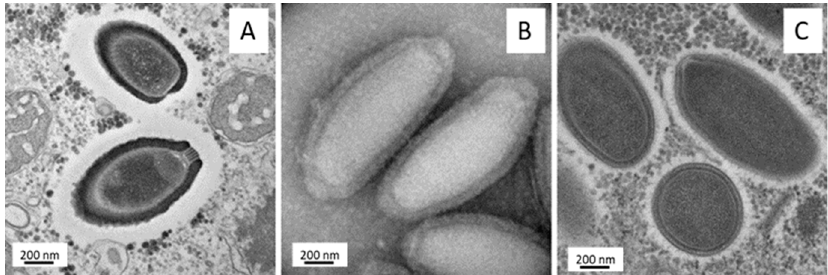
Figure 5. Transmission electron microscopy of Pithovirus massiliensis ( A ), Cedratvirus A11 ( B ), and Orpheovirus particles ( C ).